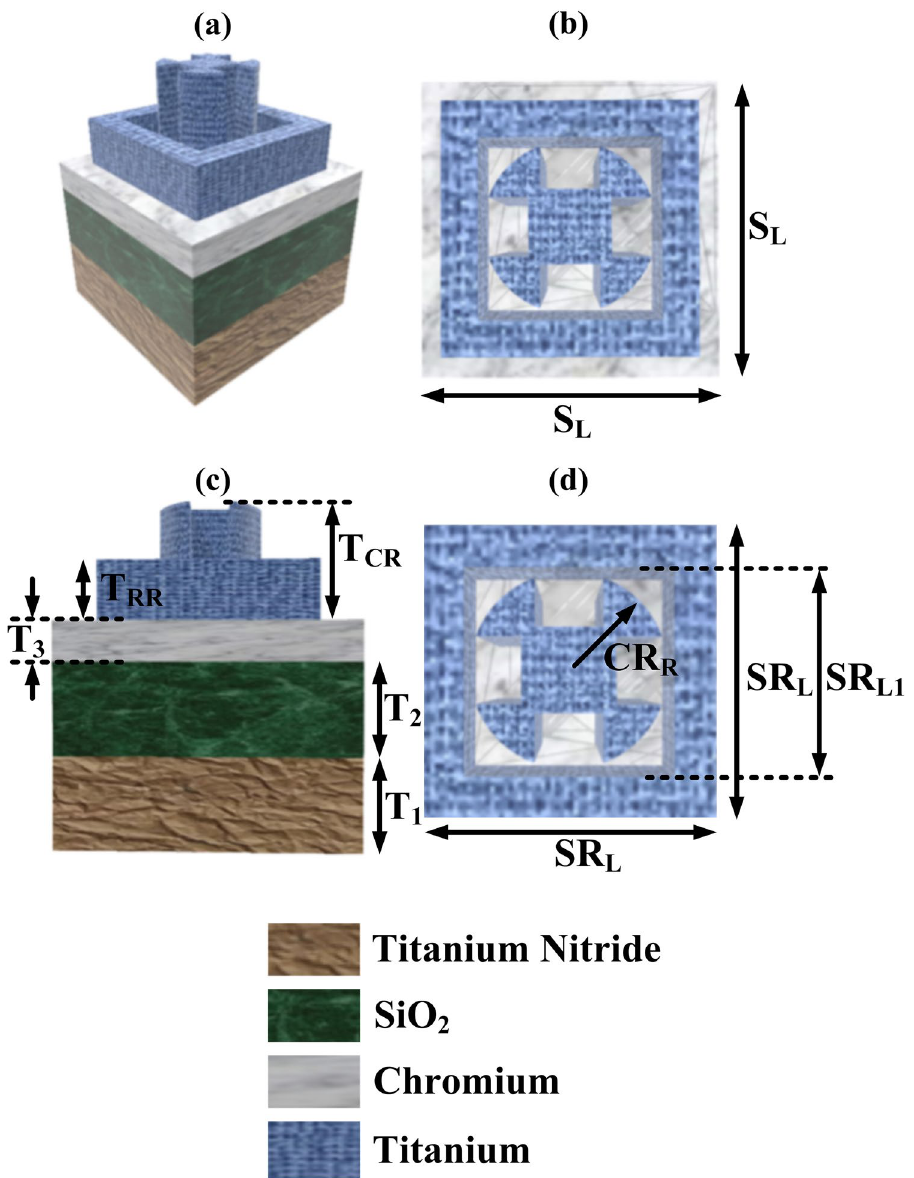
( d ) enhanced view of the multiple resonator structures of the UWBSEA and the materials utilized for the construction of the developed